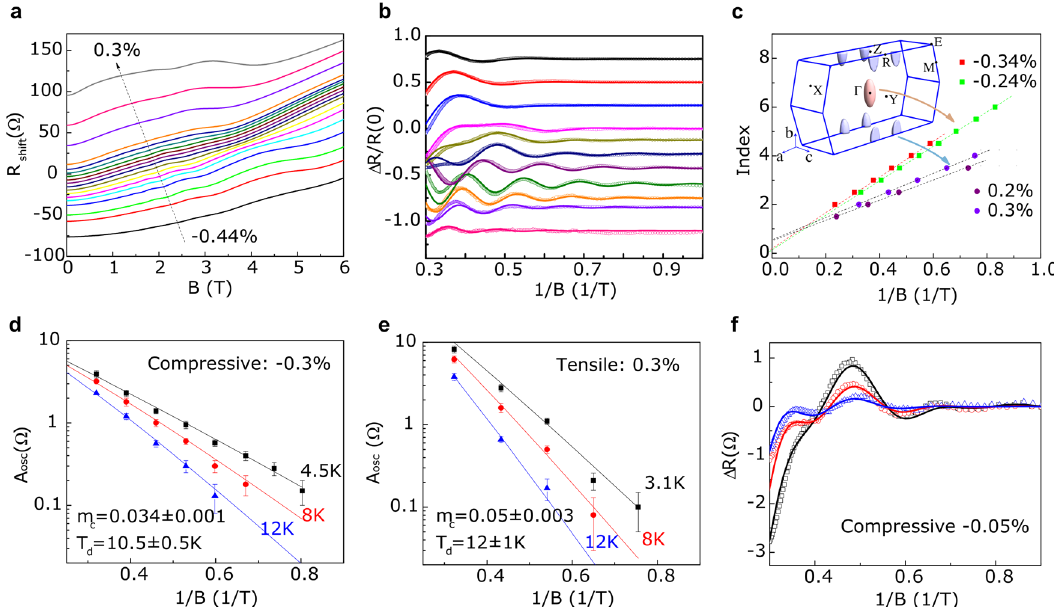
Fig. 2 Magnetotransport measurements on ZrTe 5 under strain. a Resistance versus magnetic fi eld in various external strains. The curves are shifted in proportion to the strain for clarity, from the bottom to the top: − 0.44, − 0.34, − 0.3, − 0.24, − 0.21, − 0.19, − 0.17, − 0.15, − 0.13, − 0.11, − 0.09, − 0.07, − 0.05, − 0.03, 0, 0.1, 0.2, 0.3%. b SdH oscillations versus inverse magnetic fi eld in various external strains. The curves ares shifted in proportion to the strain for clarity, from the bottom to the top: − 0.44, − 0.34, − 0.3, − 0.24, − 0.17, − 0.11, − 0.05, 0, 0.1, 0.2, 0.3%. Symbols are experimental data and solid lines are simulations using the two-component LK formula. c Landau index, obtained from SdH oscillations, versus inverse magnetic fi eld in large compressive and tensile strains (red square: − 0.34%, green sqaure: − 0.24%, brown circle: 0.2%, blue circle 0.3%). Here resistance peaks and valleys are assigned integer and half integer indices, respectively. The inset show the pockets of Fermi surface, with the Dirac band at the Γ point and a parabolic side band between the R and E points dominating the SdH oscillations under strong compressive and tensile strains, respectively. d , e SdH amplitude versus inverse magnetic fi eld and temperature in strong compressive ( − 0.3%) and tensile (0.3%) strains. The symbols are experimental data and the solid lines are fi ttings using the LK formula. From the fi ttings, the effective cyclotron mass and Dingle temperature can be obtained. The vertical error bars denote the uncertainty in identifying the SdH oscillation amplitude. f Under medium strains the SdH oscillations (open symbols) are directly simulated (solid lines) with the two-component LK formula at various temperatures: black: 3K; red: 8K; and blue: